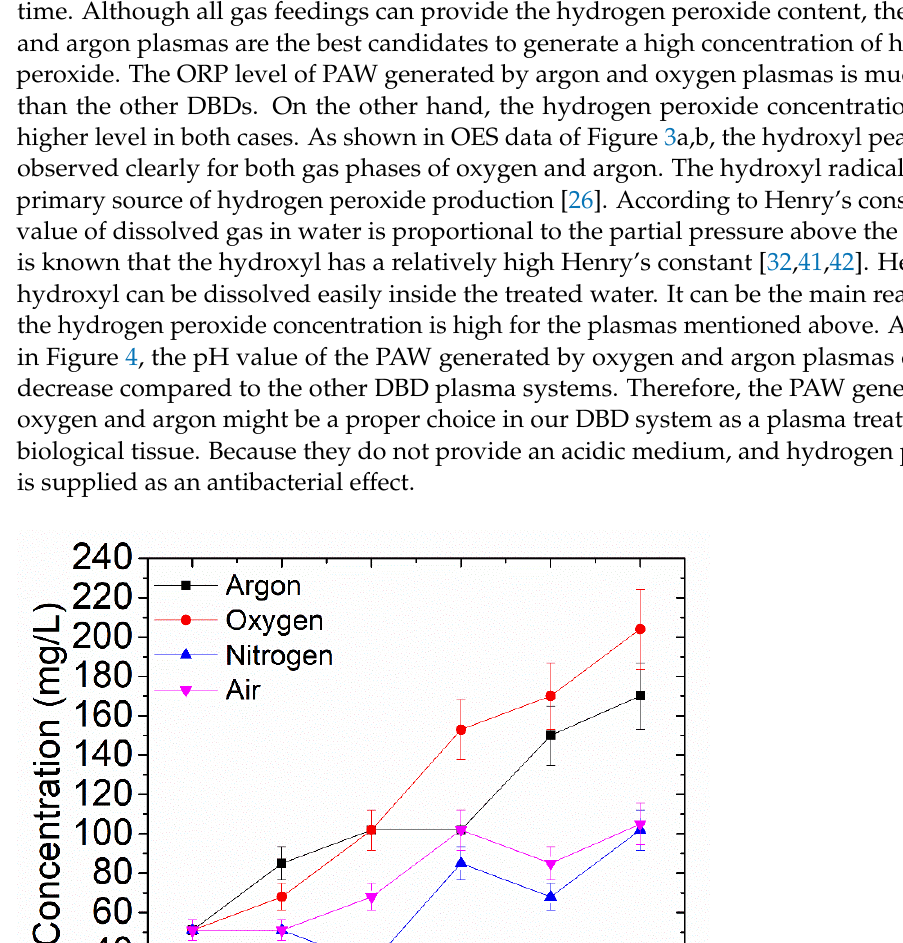
Figure 6. Nitrite and nitrate measurements inside the plasma-activated water with four gas feed- ings: argon, oxygen, nitrogen, and air using an ion chromatography system.